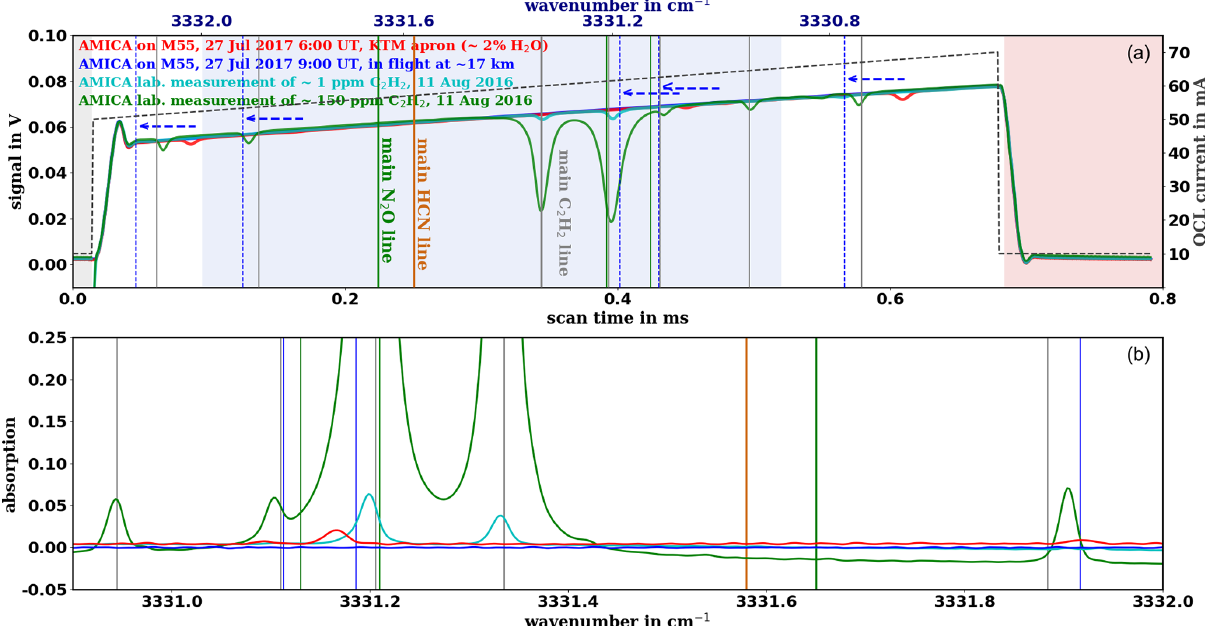
Figure 12. (a) QCL current (dashed line, right axis) and detector voltage signal past the preamplifier (left axis; ramps averaged over 300s) for AMICA cavity 2 in the 3331cm − 1 setup for a laboratory experiment sampling C 2 H 2 from a bottle and a flight from Kathmandu (see legend for colours). The wavelength scale shown on the top axis was fitted to the laboratory data. The wavelength scale during the flights was shifted so that the observed H 2 O peaks are relatively displaced (indicated by the dashed blue arrows). Three periods are marked by the coloured areas – (i) grey: only detector dark signal (with zero offset) is observed; (ii) blue: period for which absorption spectrum in the lower panel is shown; (iii) red: period after QCL stops emitting, when the signal decays exponentially due to ring down of the light in the cavity (the ring down was to fast to do a reasonable fit). (b) Measured spectra from (a) shown in absorption space (with the wavelength scale corrected). Absorption line positions coloured according to different gases are indicated in both panels by vertical lines for better